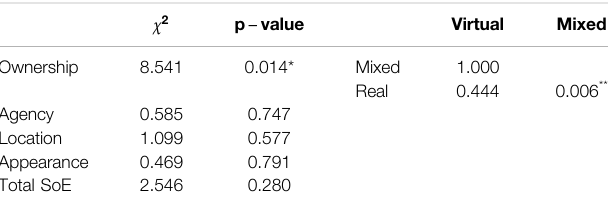
TABLE 4 | (Left) Friedman test results on the embodiment